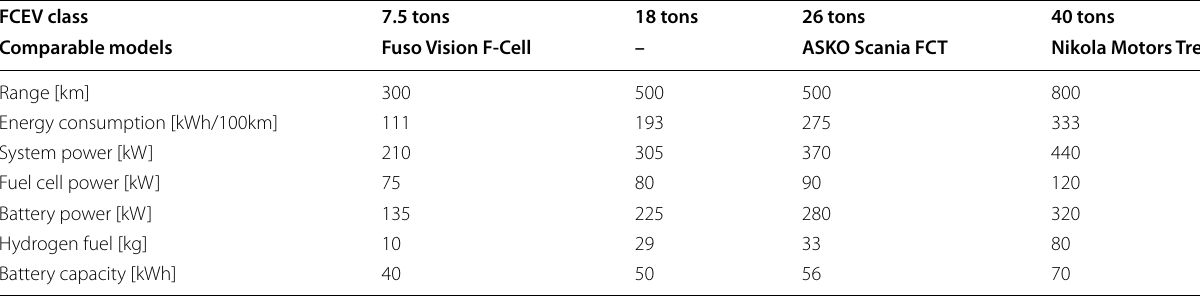
Table 1 Vehicle specifications of FCEV